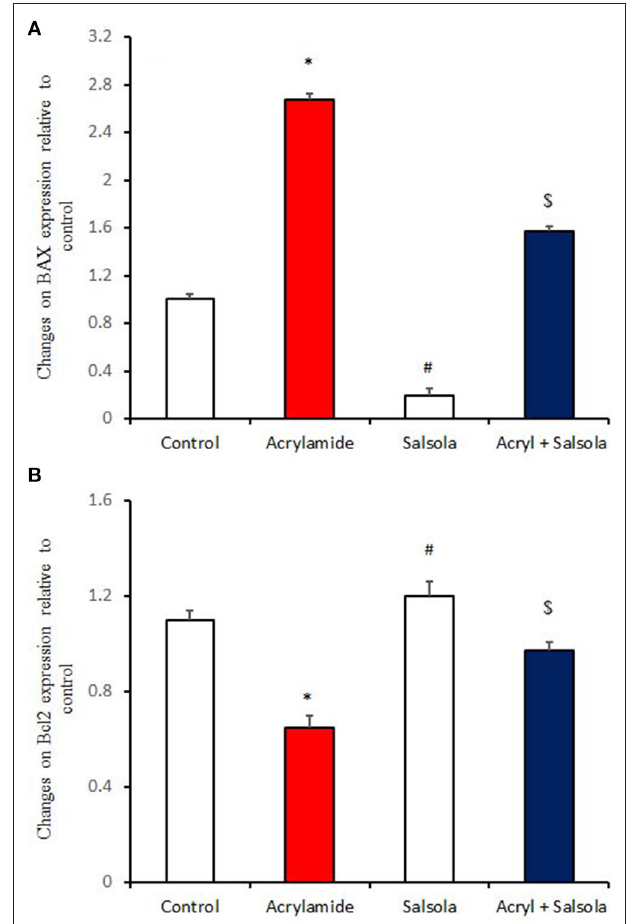
FIGURE 5 | The impact of Salsola imbricata extract on the mRNA expression of COX-2 and TGF- β 1 in acrylamide-administered rats ( n = 10). Graphic presentation of hepatic expression according to qRT-PCR analysis of COX-2 and TGF- β 1 in different groups of rats after normalization with the housekeeping gene (actin). * p < 0.05 vs. the control group; $ p < 0.05 vs. the acrylamide-administered group.